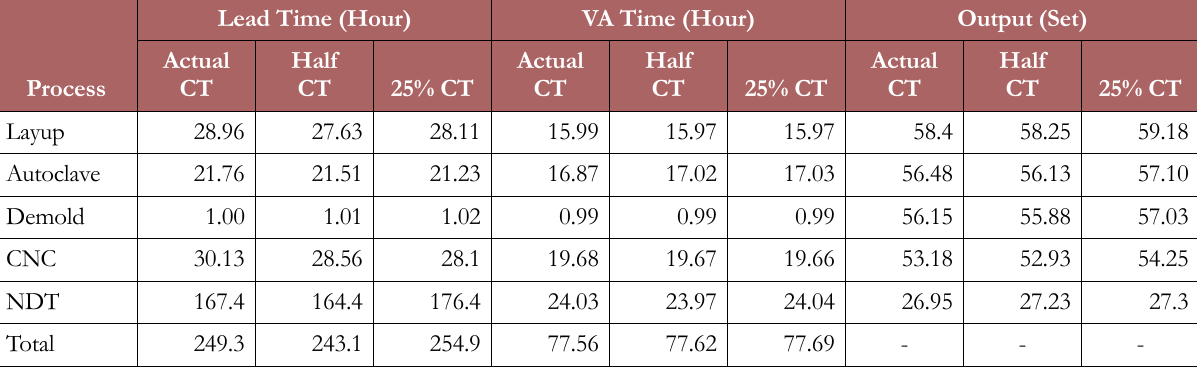
Table 4. Total Lead Time and Output of Processes under Different Transportation